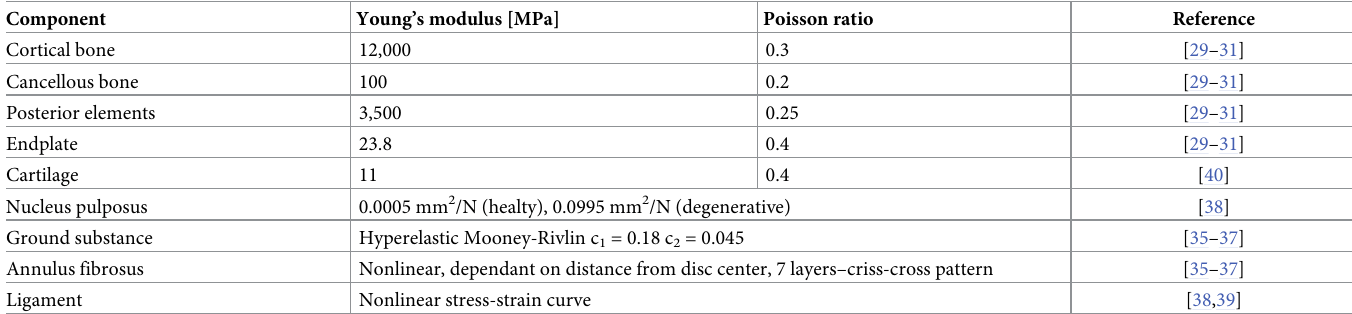
Table 1. Material properties of the lumbar